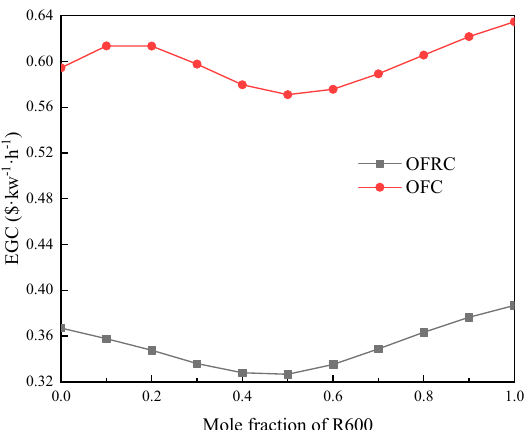
Figure 14. Variation of the electricity generation cost with the R600 mole fraction.